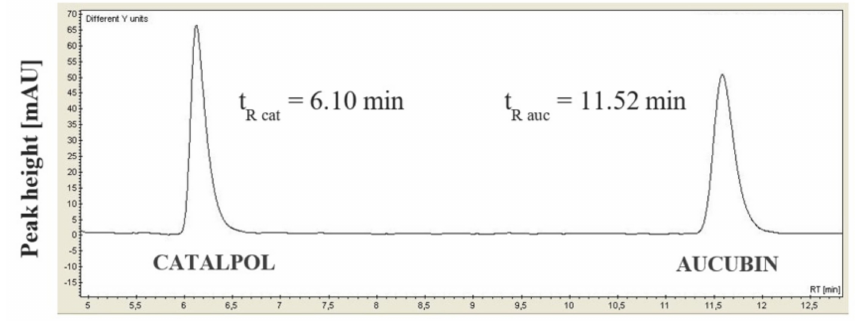
Figure 9. Chromatogram of standard solution of aucubin (50 µ g/mL) and catalpol (50 µ g/mL).